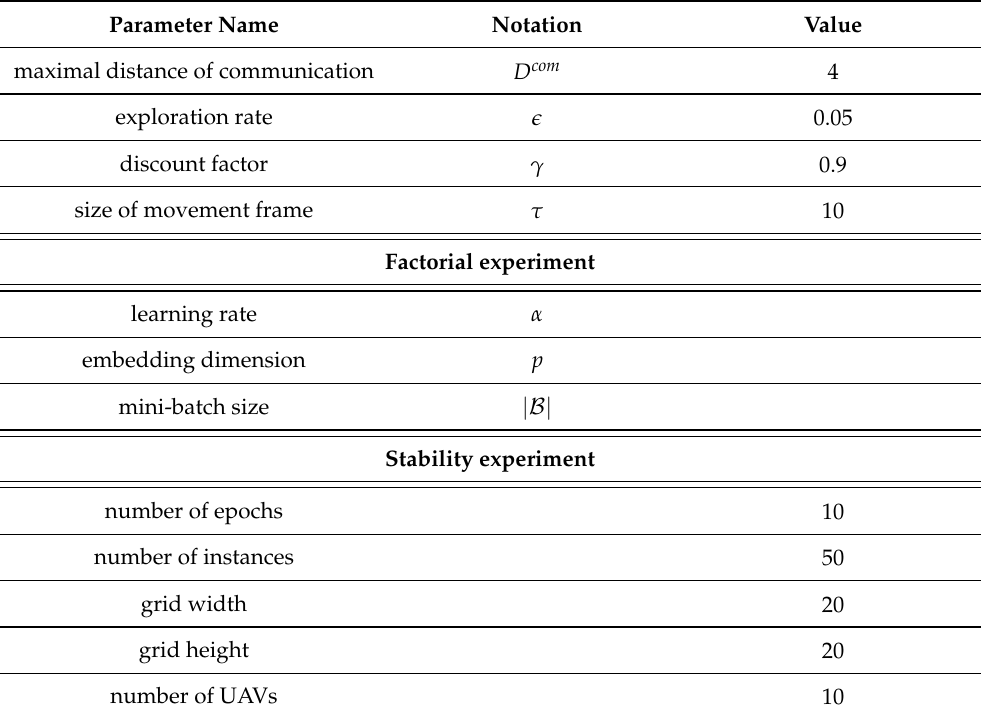
Table 1. Experimental parameters used for training